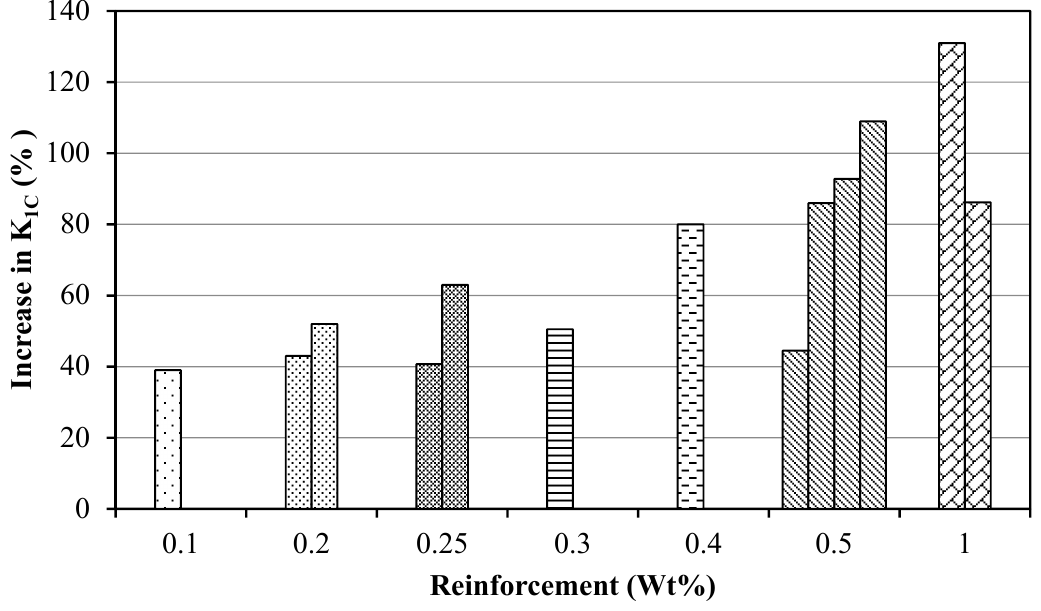
Figure 4. The weight fractions of reinforcements at which maximum K 1C was achieved in different epoxy/graphene nanocomposites and corresponding improvement (%) in K 1C (See references in Table 1).